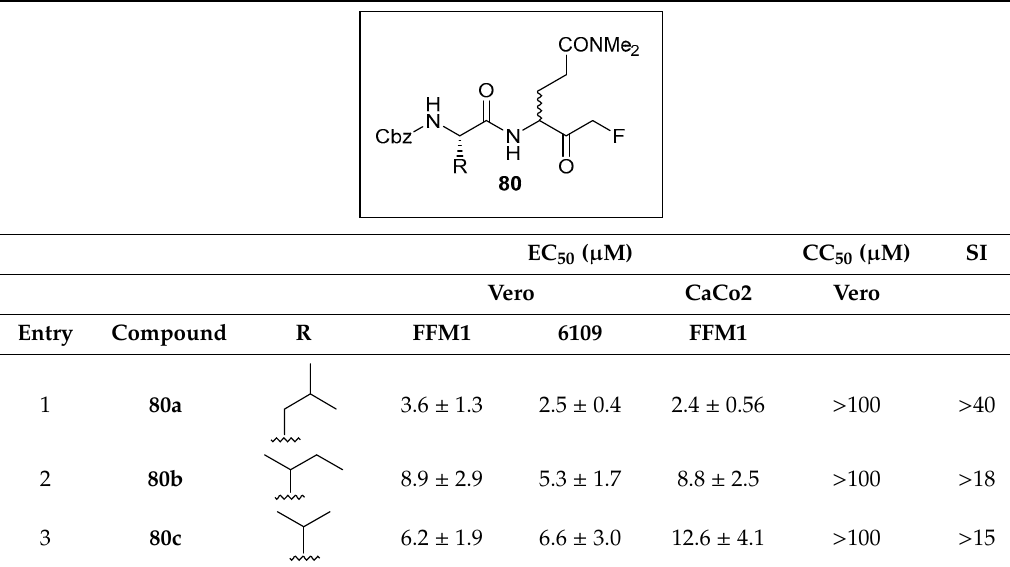
Table 2. EC 50 , CC 50 , and Selectivity Index (SI) values for a selection of dipeptidyl glutaminyl FMKs in SARS-CoV-infected Vero and CaCo2 cultures [4].